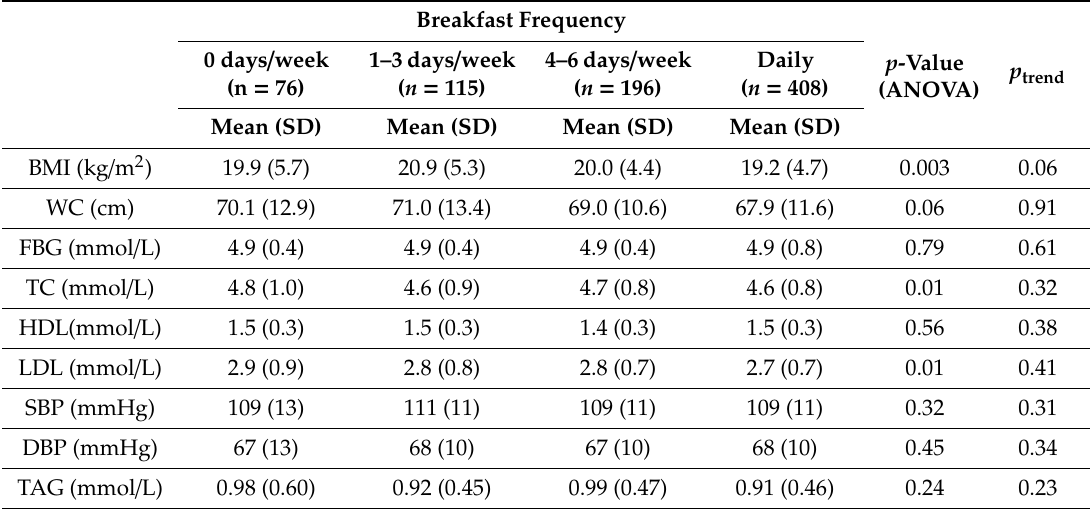
Table 2. Description of cardiovascular disease (CVD) risk factors by breakfast frequency ( n = 795). Breakfast Frequency